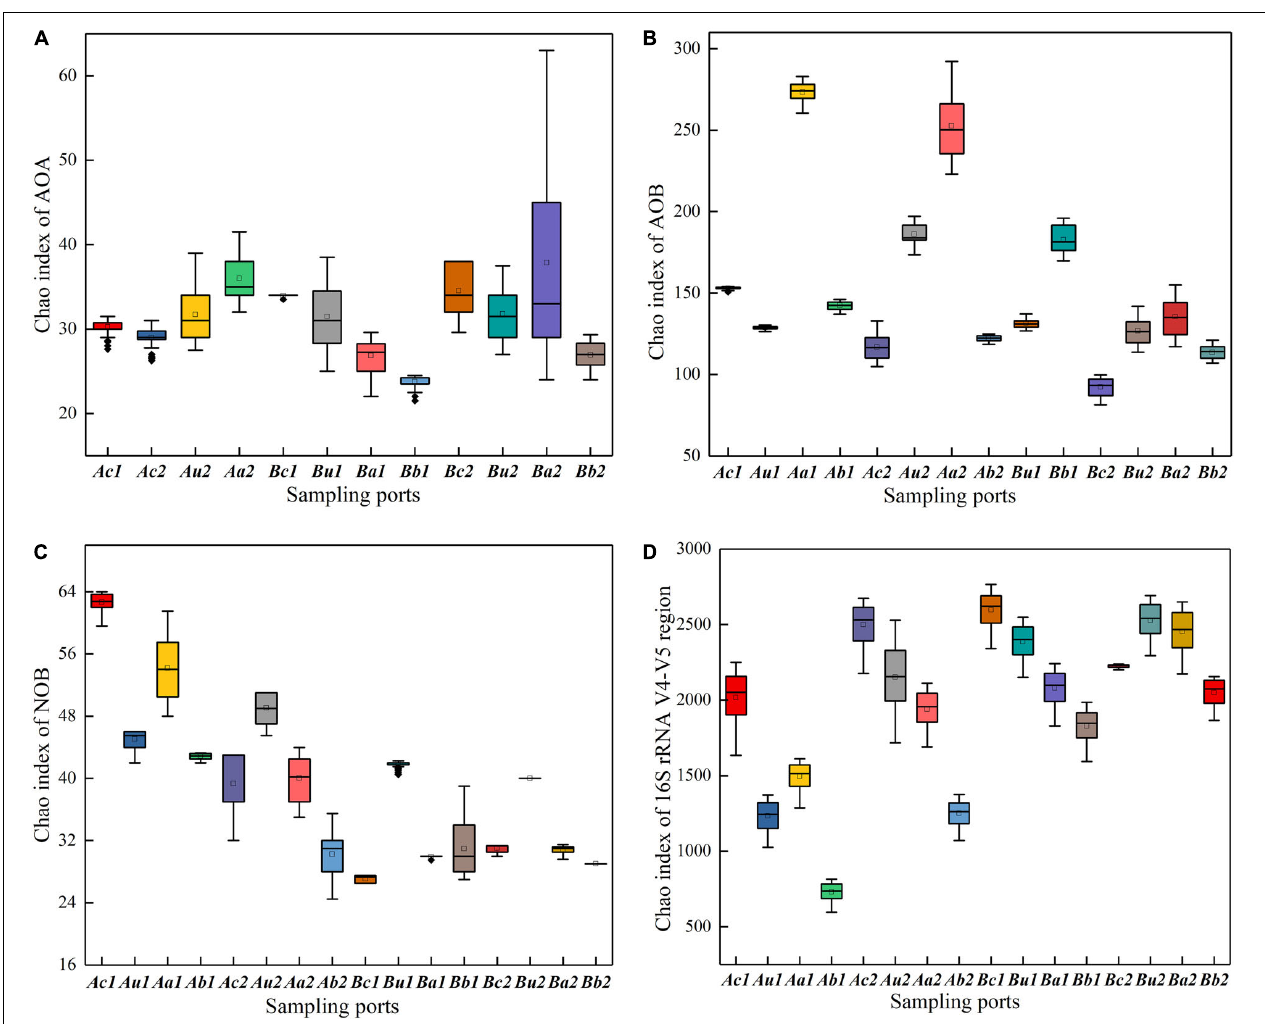
FIGURE 4 | Relative change of Chao indexes of panels (A) AOA, (B) AOB, (C) NOB, and (D) 16S rRNA V4–V5 region, at different sampling points of TFCW-MFCs. The horizontal line in the box represents the median. The size of the box represents the data dispersion (Interquartile range =